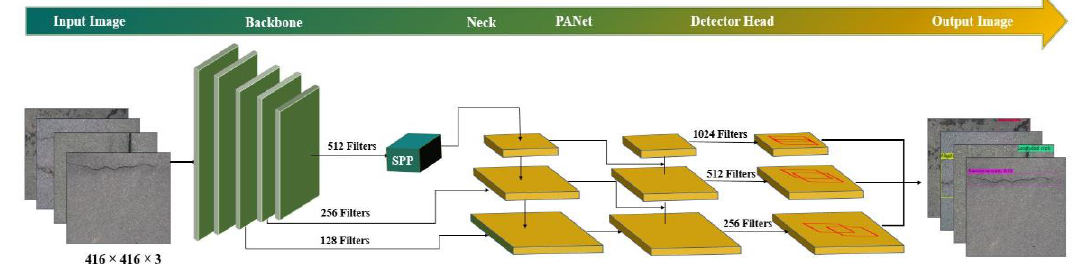
Figure 2. The proposed automatic crack recognition deep learning network architecture.